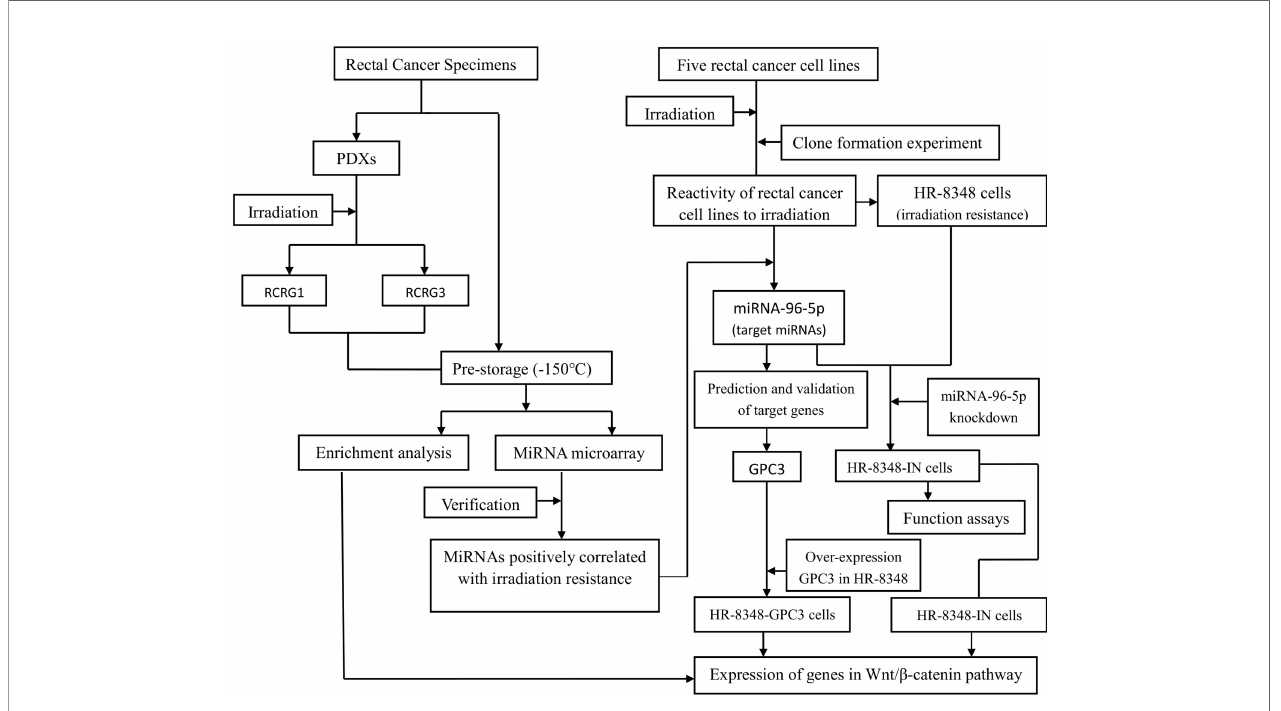
FIGURE 2 | A fl owchart of each step in this